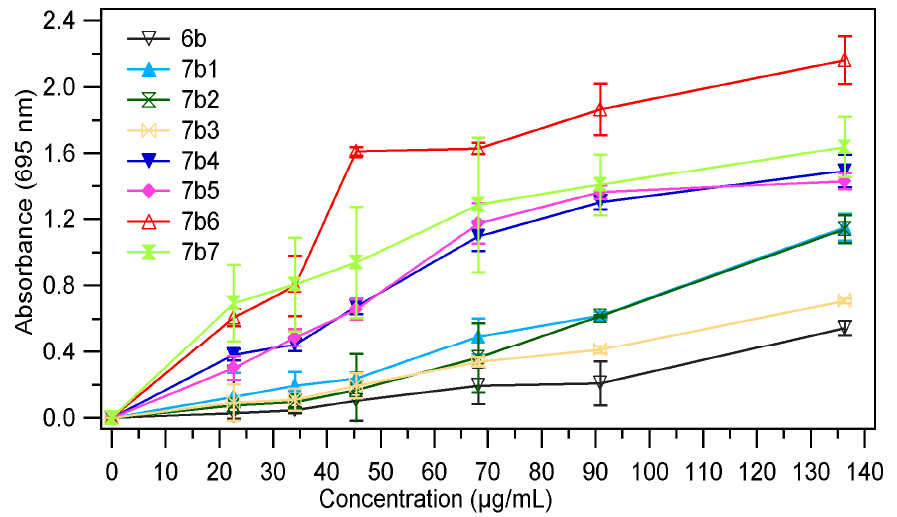
in ref. to 6b . 1–7